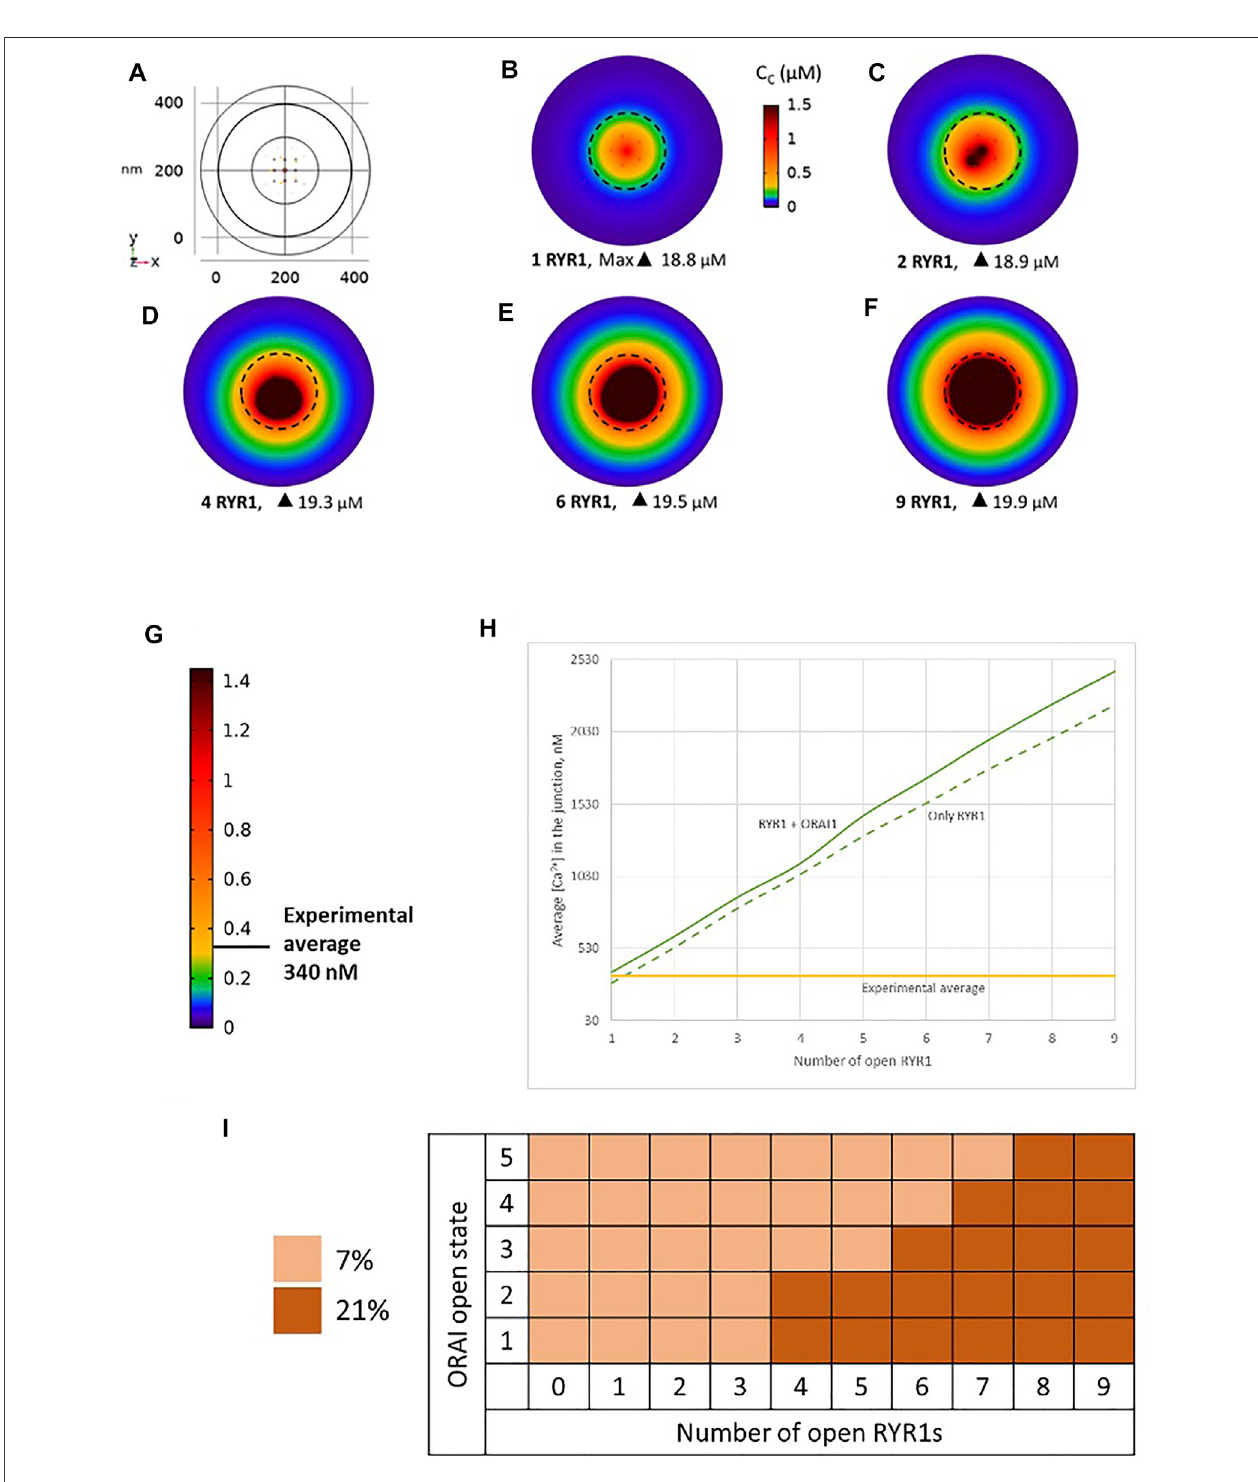
FIGURE 2 | Simulated Ca 2+ microdomains resulting from the opening of RYR1 inside the junctions, which in turn induces the opening of ORAI1 channels in the junctionsasaresultoflocaldepletionofERCa 2+ (A) UpperviewofthearrangementoftheORAI1channelsonthePMofthejunction(yellowdots)andoftheRYR1onthe ERM(reddots)usingCOMSOL (B – F) Steady-stateCa 2+ pro fi lesinthejunctionwhenopening1,2,4,6and9RYR1simultaneously (B) to (F) respectively.Shownarethe pro fi les 22 ms after opening of the RYR1, but these stabilize very rapidly, after a few ms (G) Extended colour code with marking of the average amplitude of a microdomain in unstimulated T cells (Diercks et al., 2018) (H) Evolution of the amplitude of the simulated Ca 2+ microdomains with the number of simultaneously open